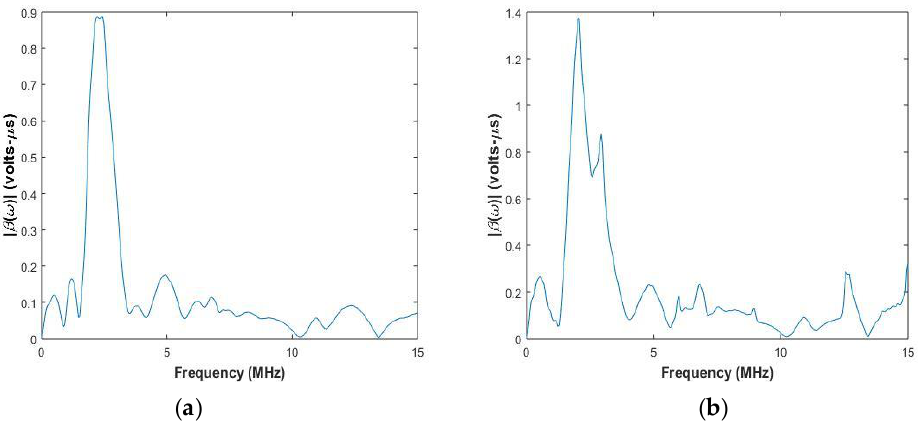
Figure 4. System function of pair of elements with center frequency of 2.25 MHz used for testing ( a ) Aluminium ( b ) CFRP laminate.